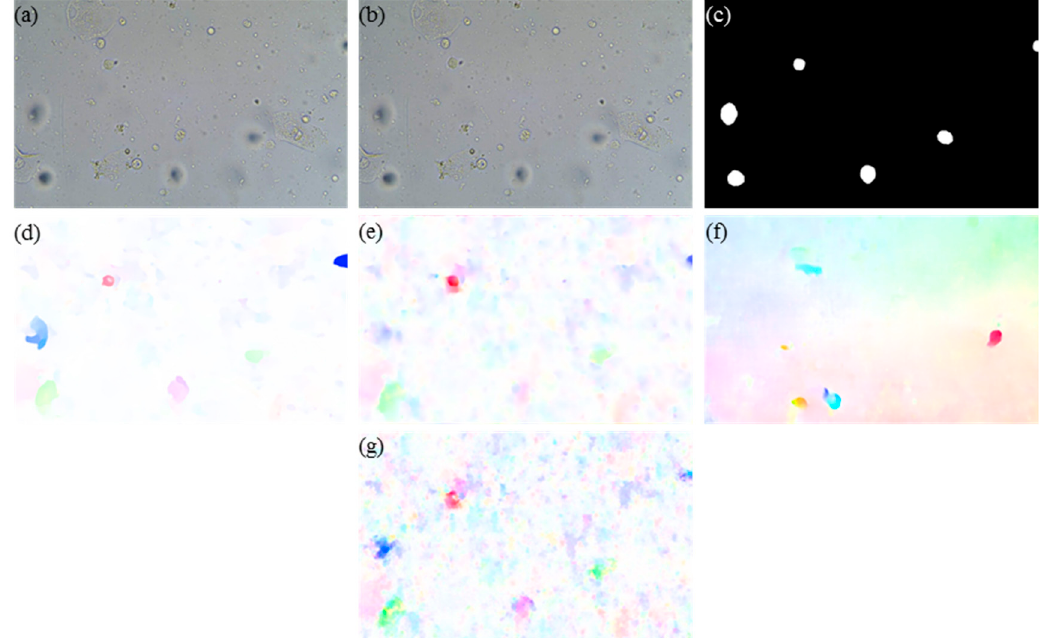
Figure 8. Comparison between 4 optical flow calculation methods based on deep learning. ( a , b ) show the two adjacent frames; ( c ) shows the TV ground truth of frame ( a ); ( d ) to ( g ) are the visualized images of optical flow calculated by Flownet2.0 [19], LiteFlowNet2 [13], Pwcnet [20], and Spynet [21].